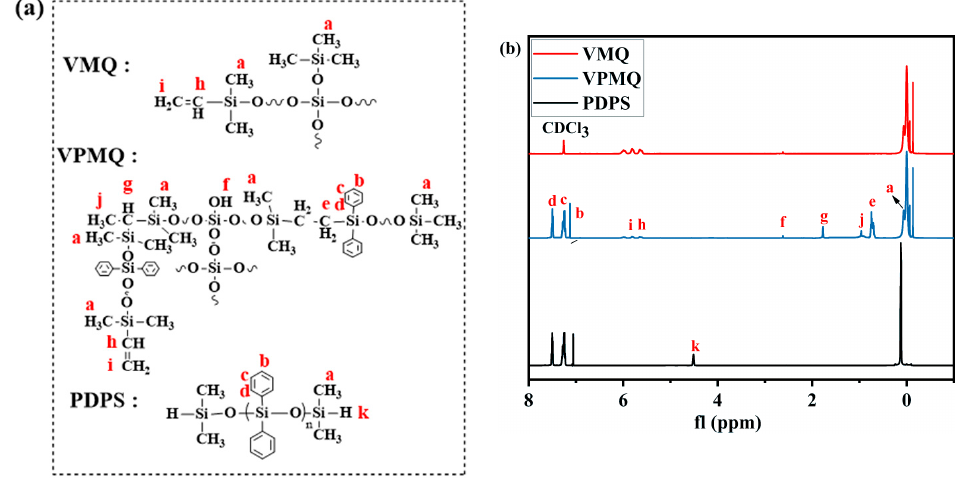
Figure 3. 1 H NMR spectrum of VMQ, VPMQ and PDPS: ( a ) Molecular formula of VMQ, VPMQ and PDPS; ( b ) 1 H NMR spectrum of VMQ, VPMQ-4 and PDPS.